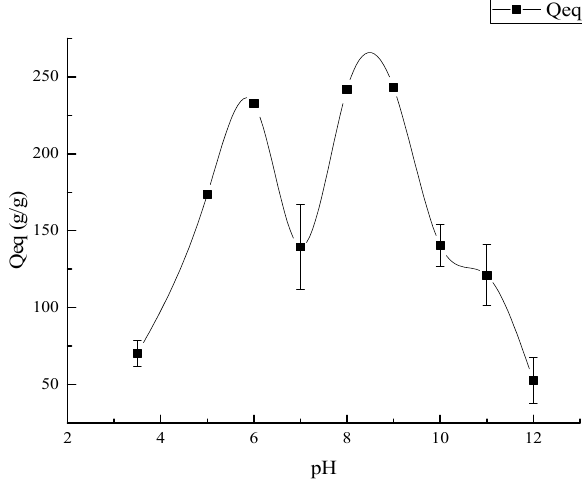
Figure 13. The influence of pH values on absorbency.